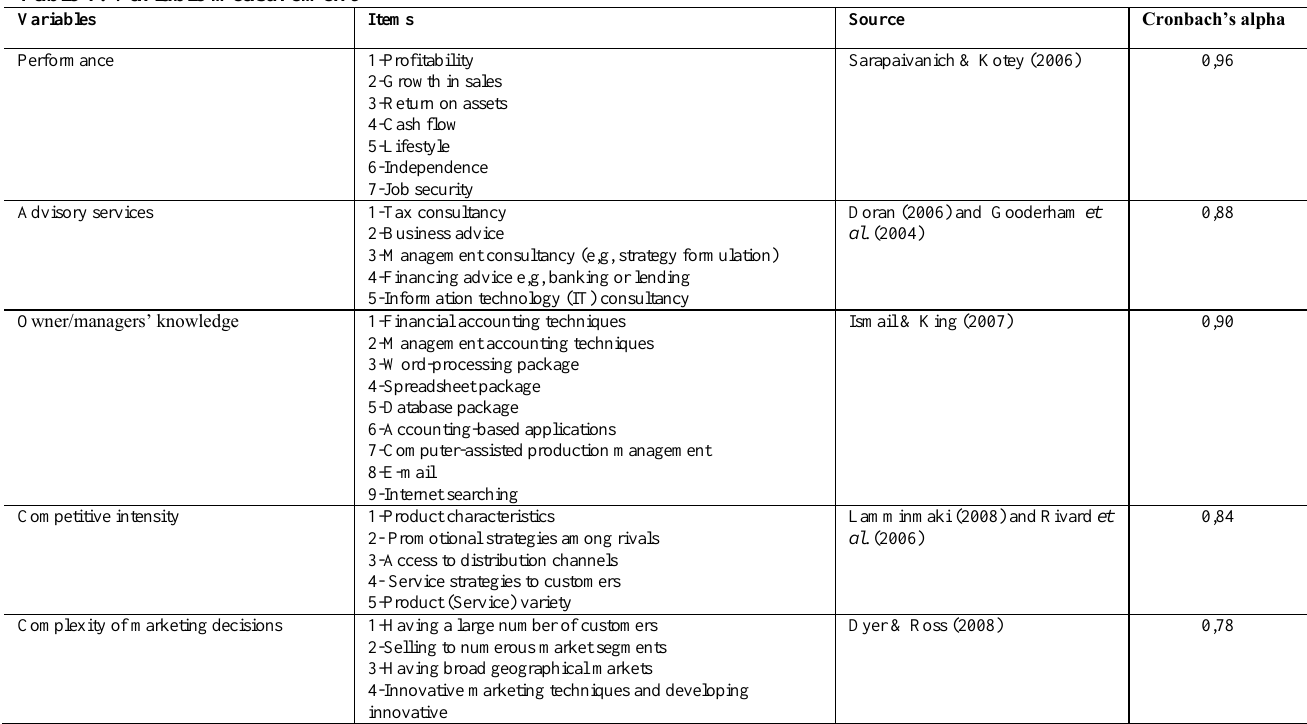
Table 1: Variable measurement